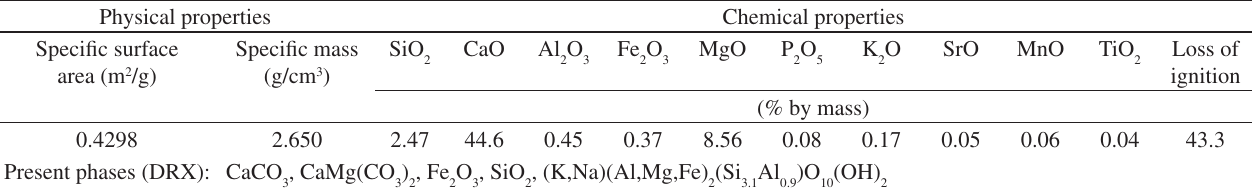
Table 2. Physical and chemical characteristics of the carbonate filler.